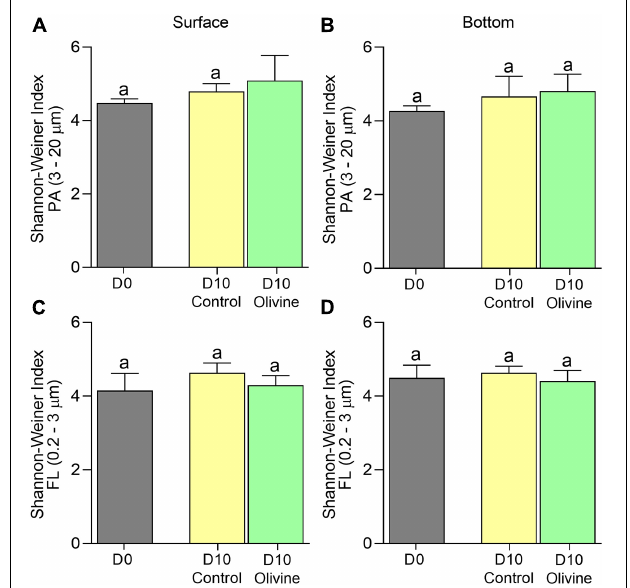
FIGURE 2 | Changes of dissolved silicate concentration (A,B) DSi, µ mol kg − 1 , pH (C,D) , and total alkalinity (E,F) µ mol kg − 1 in initial and 10-day incubated seawater with or without olivine addition, from the surface (A,C,E) and bottom layers (B,D,F) of the sampling site. The vertical bar indicates the standard deviation ( N = 3), and different letters indicate significant differences ( p < 0.05).